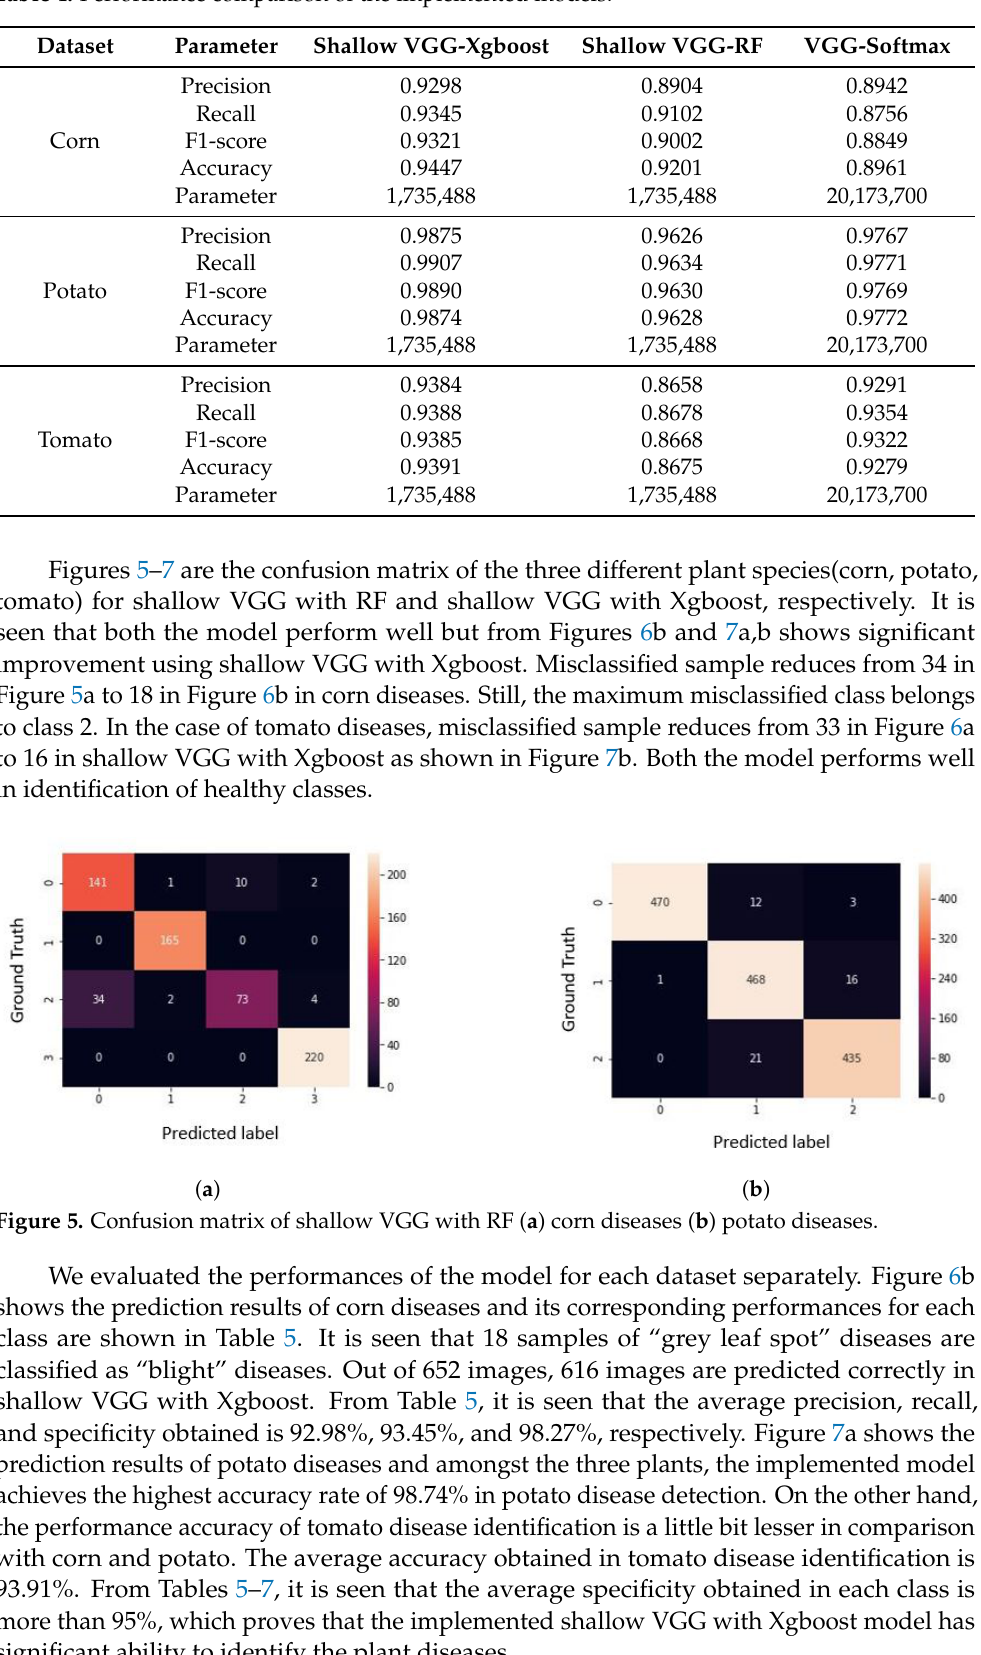
Table 4. Performance comparison of the implemented models.